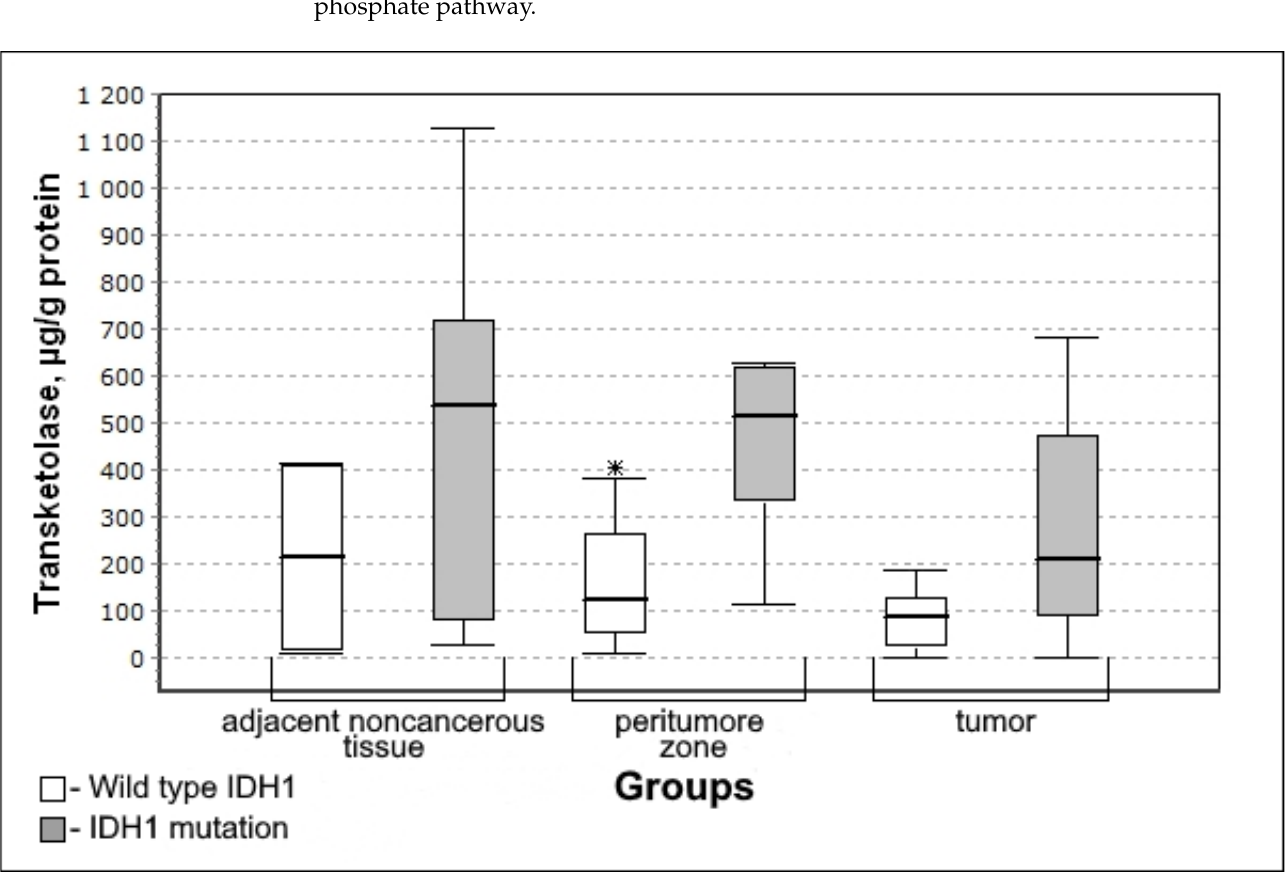
Smirnov criterion p = 0.1). This trend is observed both for adjacent noncancerous tissues